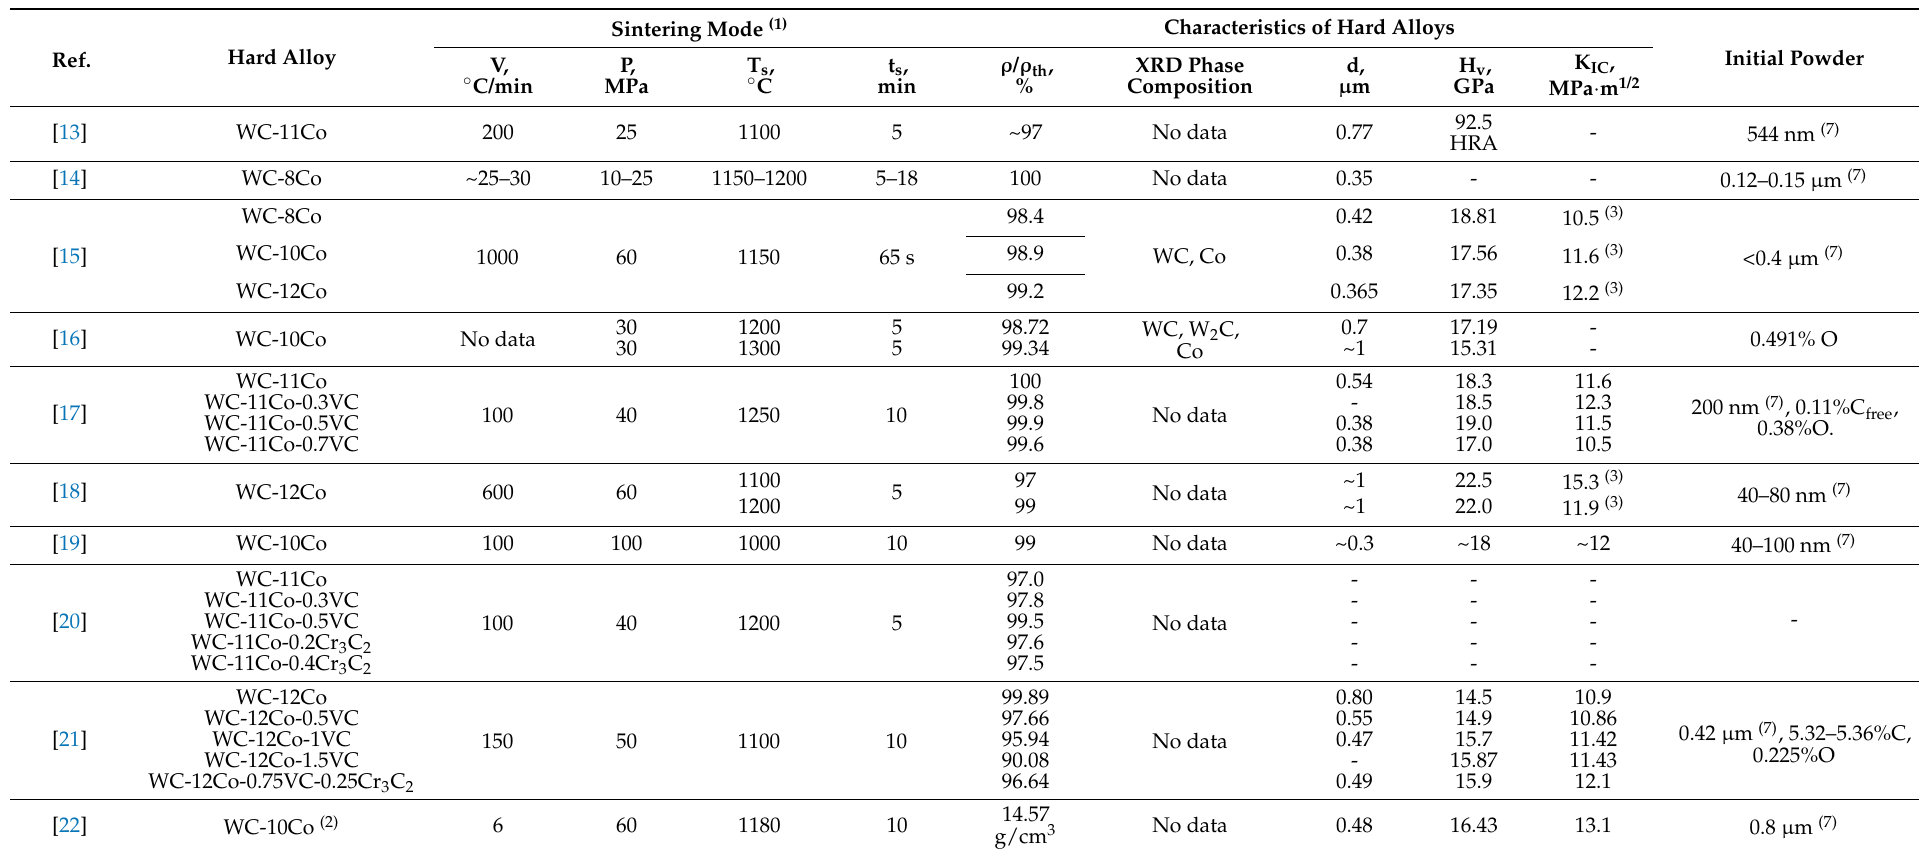
Table A1. Characteristics of specimens of fine-grained hard alloys WC-(8-12)Co obtained by SPS. Overview of the literature data.